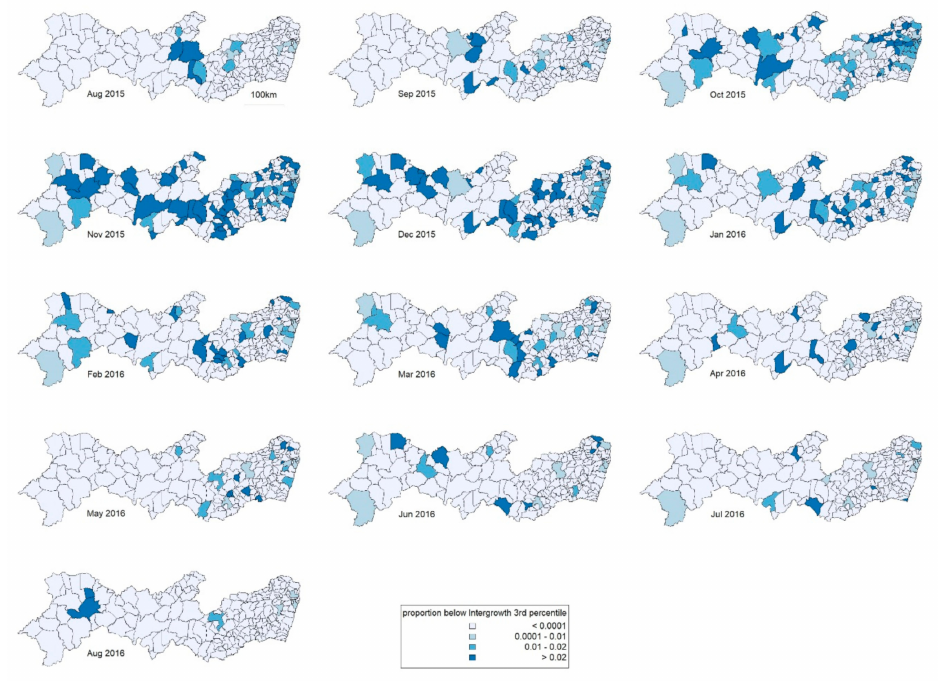
Figure 3. Maps of raw microcephaly prevalence over